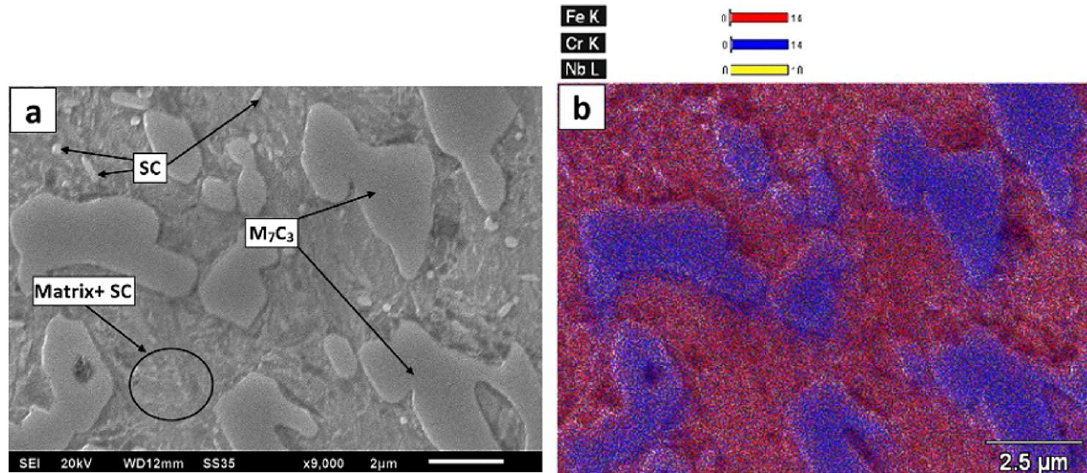
Figure 4. Microstructure of the HCCI0%Nb alloy (a) SEM; and (b) chemical